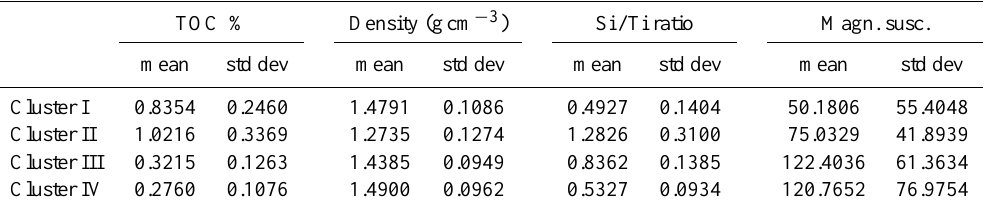
Table 2. Mean and standard deviation (std dev) of total organic carbon (TOC), density, Si/Ti ratio and magnetic susceptibility (Magn. susc.) of clusters I to IV.